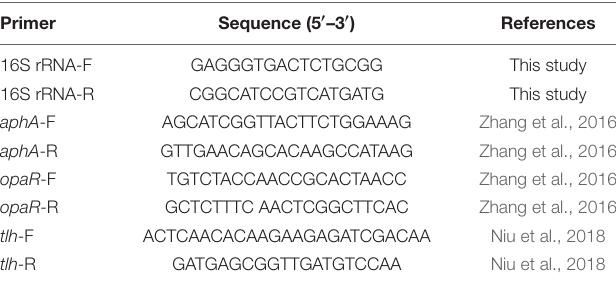
TABLE 1 | List of primers for